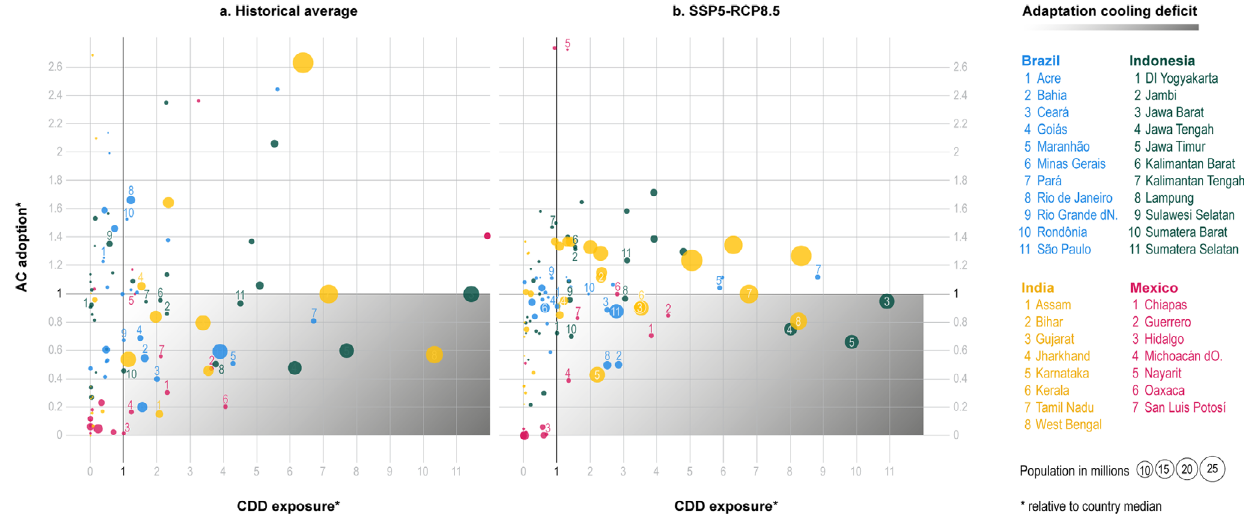
Fig. 4 Adaptation cooling de fi cit. Current situation ( a , latest wave available) and future projections in 2040 with RCP8.5 warming and SSP5 ( b ) computed with Cooling Degree Days (CDDs). Bubble size proportional to the current number of households relative to each country ’ s maximum. For the historical period, the following waves are used: Brazil, 2018 India, 2012, Indonesia, 2017, Mexico, 2016. Colors are used to differentiate the four countries. See http:// www.energy-a.eu/cooling-de fi cit/ for the interactive online